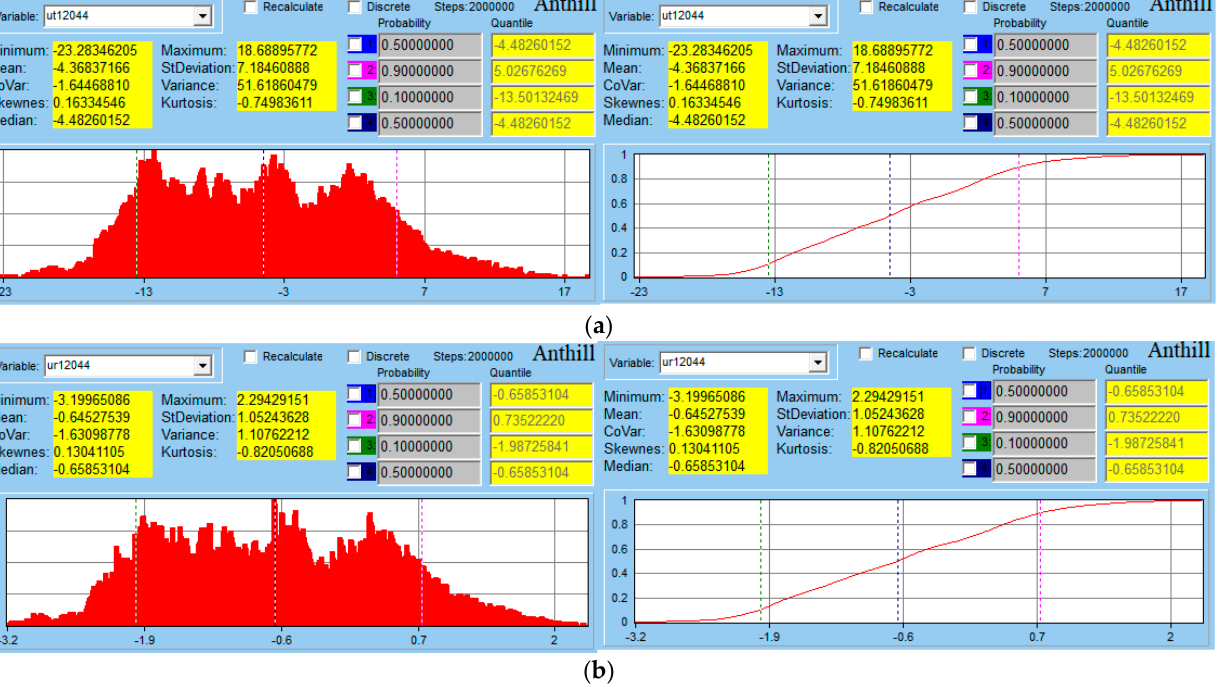
Figure 15. Histograms and distribution functions for node ’12,044’ ( a ) tangential components of crustal surface displacement, ( b ) radial components of crustal surface displacement (sw MSC.Marc Mentat and Anthill).